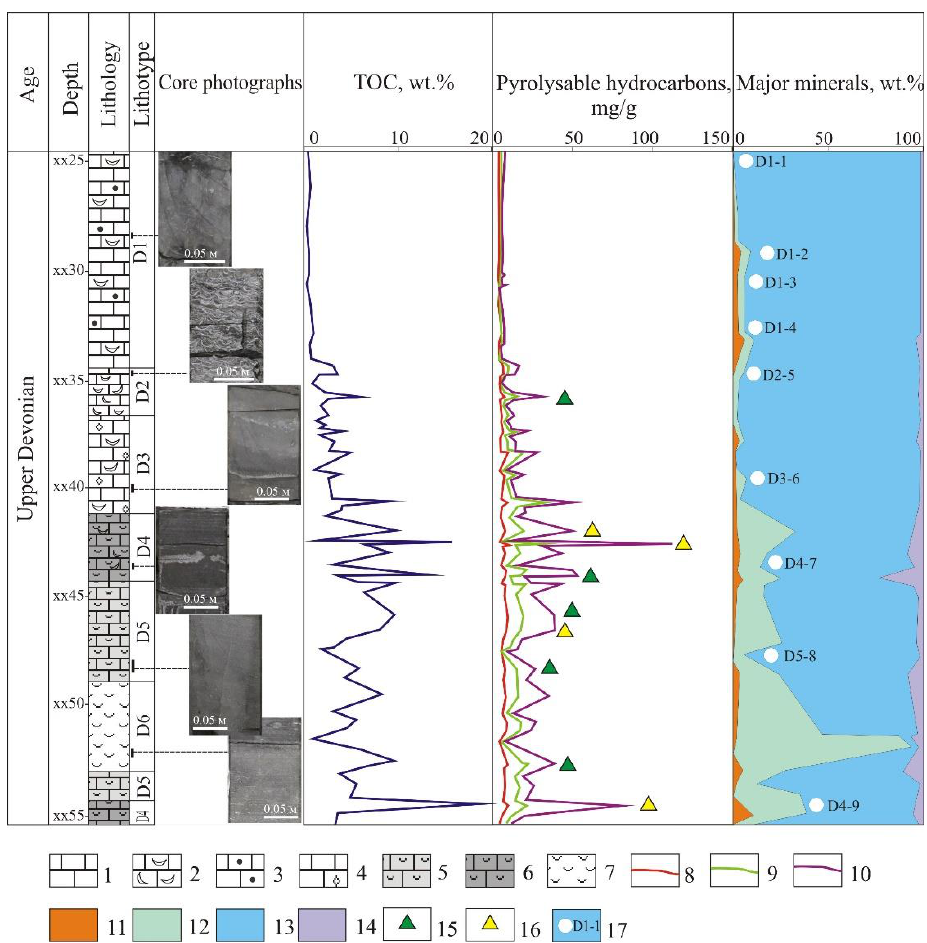
Figure 3. General characteristic of the studied section of Upper Devonian deposits (lithology com- position and characterization of OM). 1—limestone; 2—bioclastic limestone; 3—micro-clotty lime- stone; 4—crystalline limestone; 5—organic-rich siliceous limestone (TOC 4–10 wt.%); 6—organic-rich siliceous limestone (TOC > 10 wt.%); 7—siliceous rock; 8—gas and light oil from pyrolyzable components, 9—heavy oil from pyrolyzable components; 10—products of kerogen cracking from pyrolyzable components; 11—clay minerals, 12—siliceous minerals; 13—carbonates; 14—others minerals (feldspar, pyrite, amphibole etc.); 15—samples of non-distinct separation of the peaks S4 and S5; 16—fully superimposing S4–S5; 17—samples of primary water saturation.